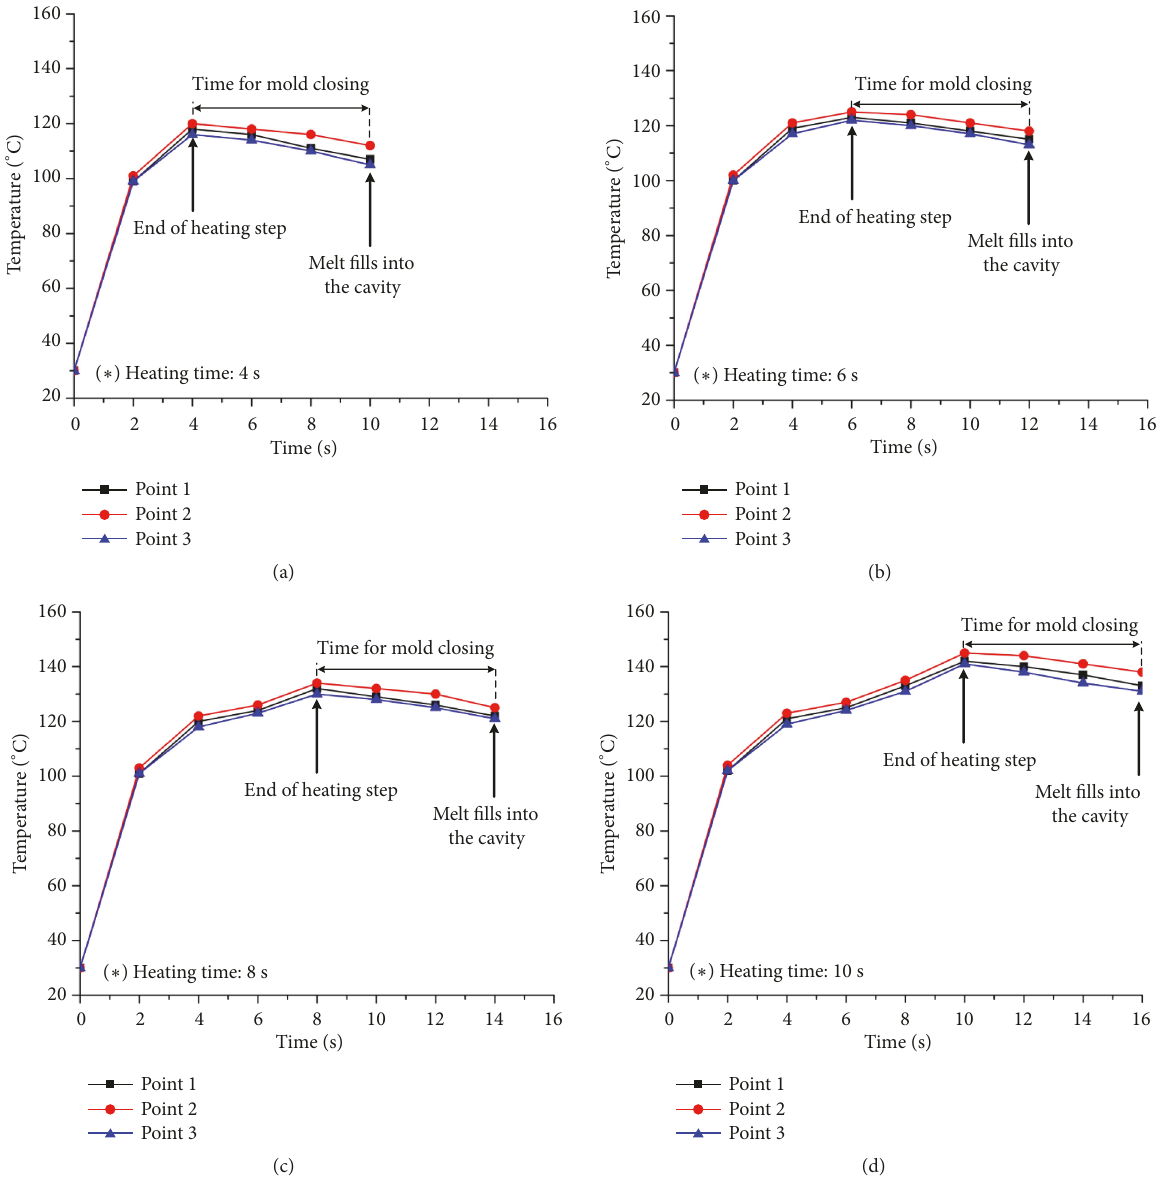
Figure 18: Temperature histories of the thin rib mold surface at three